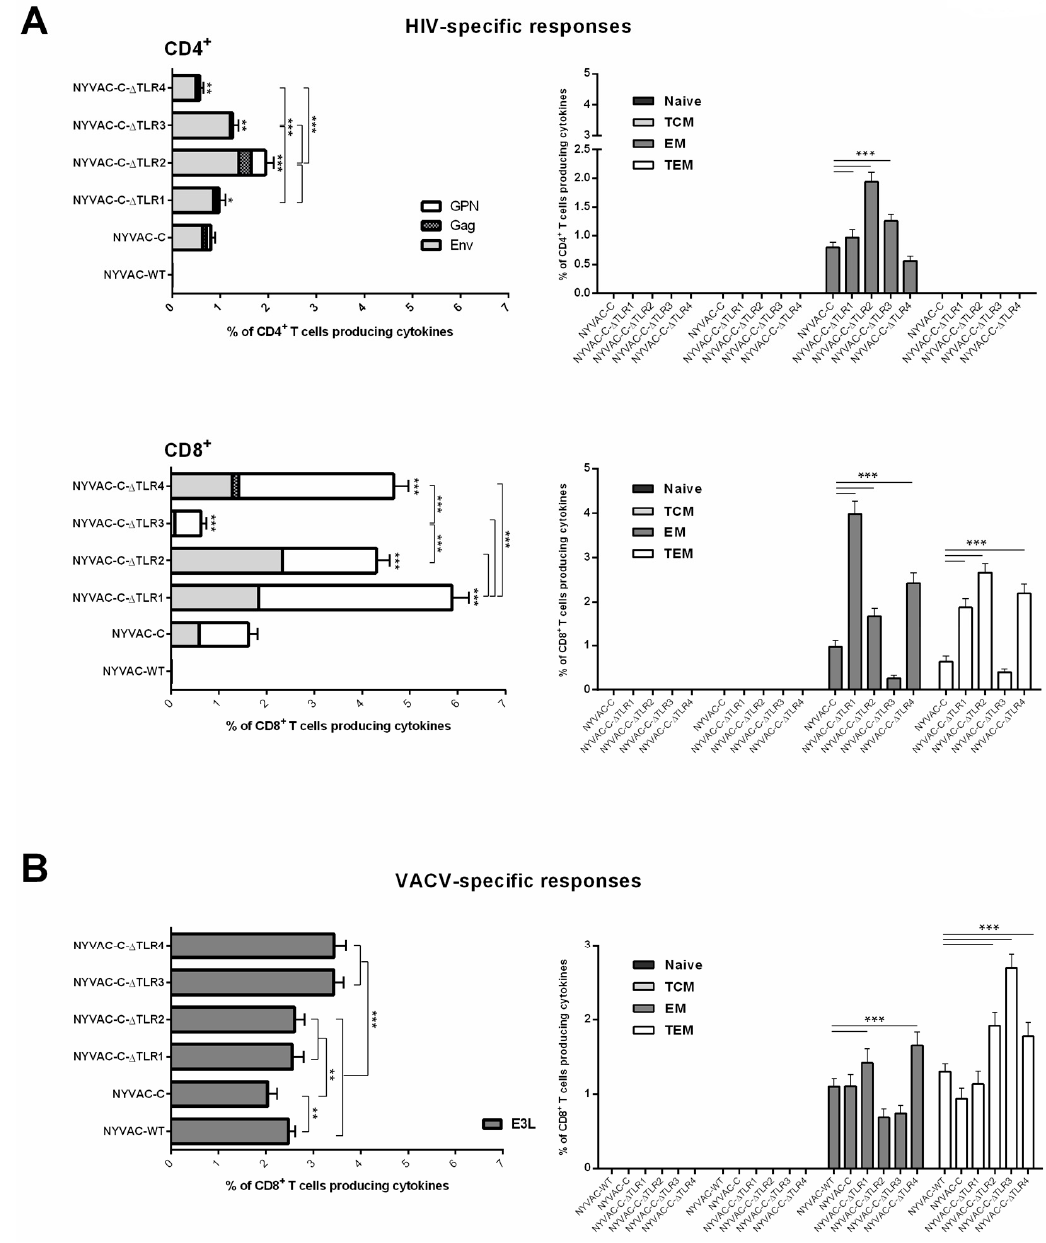
Figure 3. Cellular immune response elicited by NYVAC-C recombinant after sequential deletion of VACV-TLR inhibitors A46R , A52R , K7R and B15R . Magnitude and phenotypic profiles of ( A ) memory HIV-1-specific CD4 + (top) and CD8 + (bottom) T cells and ( B ) memory VACV-specific CD8 + T cells. The vaccine-induced cellular immune response was characterized by multi-parameter flow cytometry at 53 days after the last immunization. Values indicate the sum of the percentages of T cells that secrete IFN- γ and/or TNF- α and/or IL-2 in response to Env plus Gag plus GPN peptide pools (for HIV-1-specific responses) or to E3 peptide (for VACV-specific responses). Background percentages were subtracted from all data. The phenotype of the vaccine-induced memory responses was determined based on expression of CD44 and CD62L surface markers on activated T cells as follows: Naïve (CD44 − CD62L + ), T central memory (TCM; CD44 + CD62L + ), T effector memory (EM; CD44 + CD62L − ) or T terminal effector memory (TEM; CD44 − CD62L − ). * p < 0.05; ** p < 0.005, *** p < 0.001. Significant differences compared to the NYVAC-C group (for HIV-1 response) are indicated above each column.